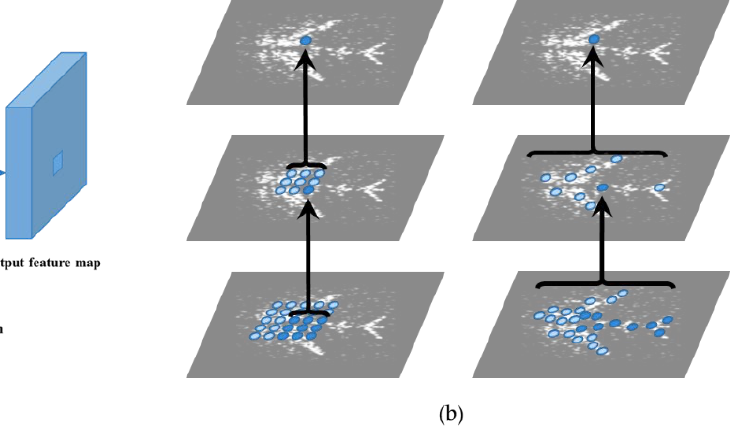
Figure 6. Illustration of DCM ( a ) Schematic diagram of the deformable convolution ( b ) Receptive field of standard convolution and deformable convolution. Top: A activation unit from a 3 × 3 convolution kernel on the top feature map. Middle: The sampling positions from the feature map of the previous layer. Bottom: the sampling positions of two layers of 3 × 3 convolution kernel on the top feature map.